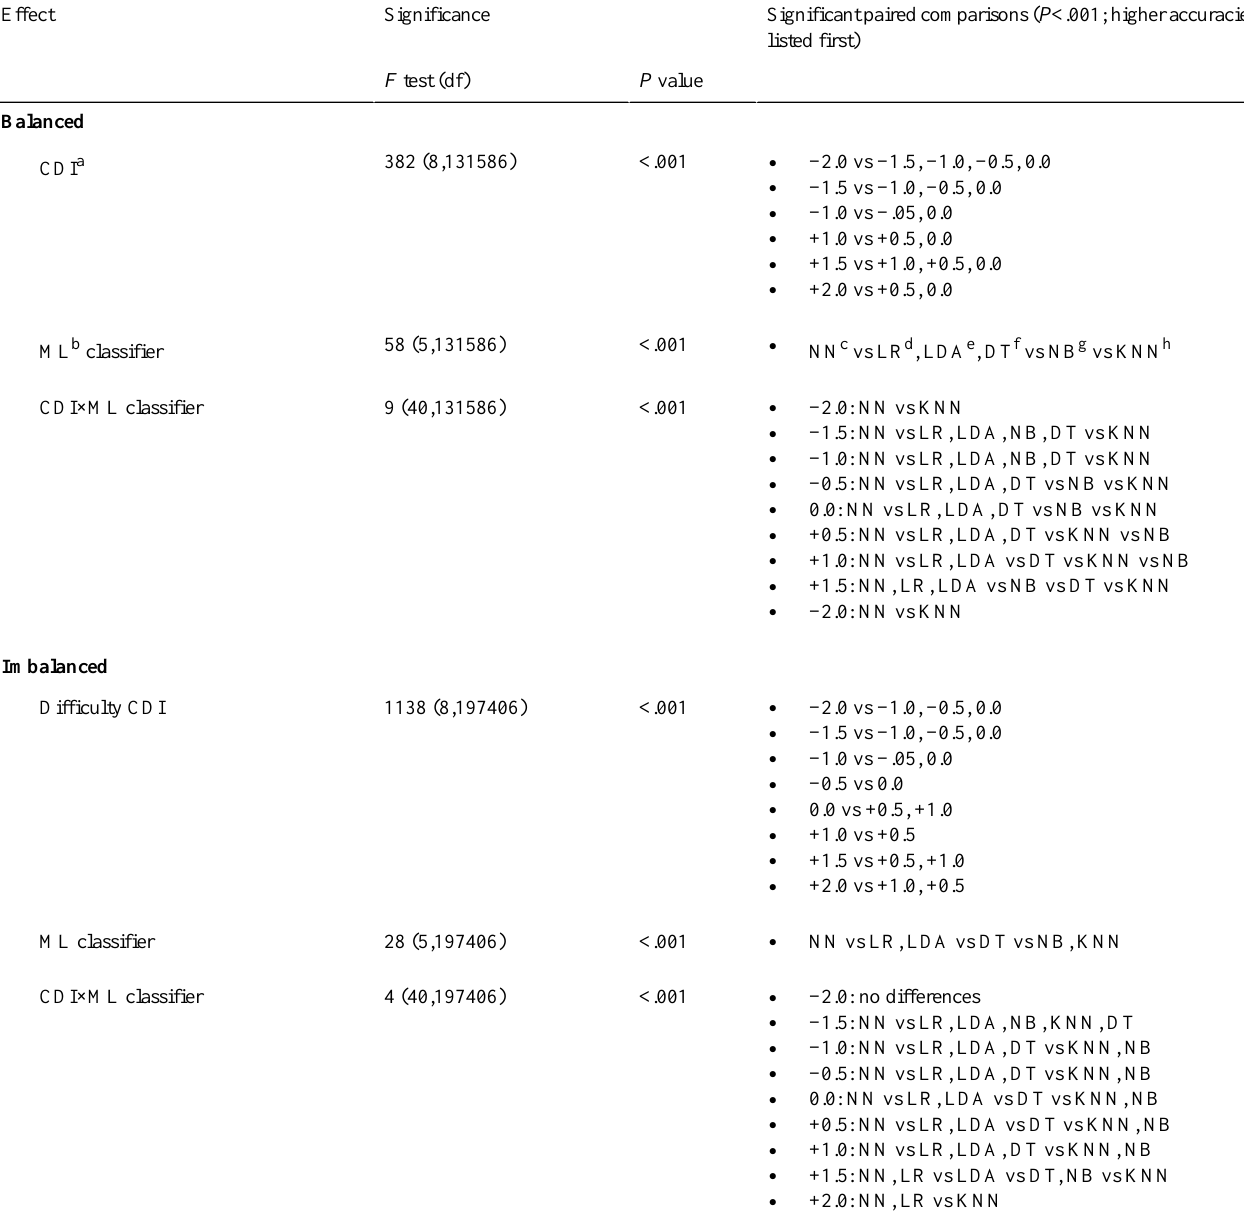
Table 11. Tests of the effects of classification, classifier, and their interaction for the electronic intensive care unit data set.